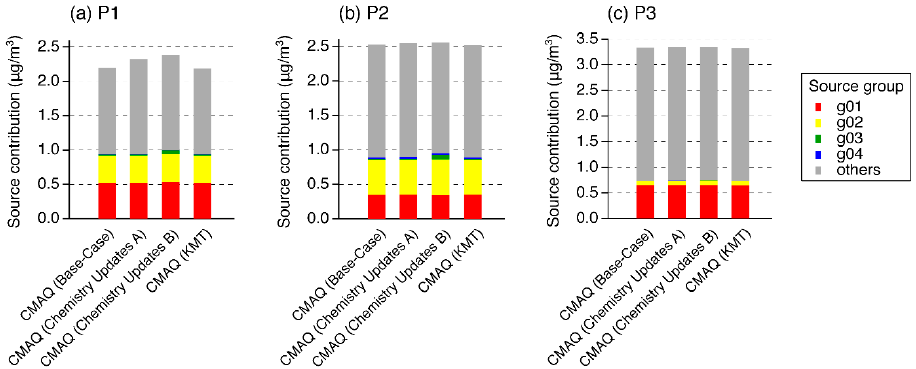
Figure 8. Spatial distributions of source contributions g01, g02, and other sources calculated by CMAQ base-case simulation, averaged during the analyzed periods defined as ( a ) P1, ( b ) P2, and ( c ) P3. Note that the color scale for g02 is different from that of g01 and other sources.